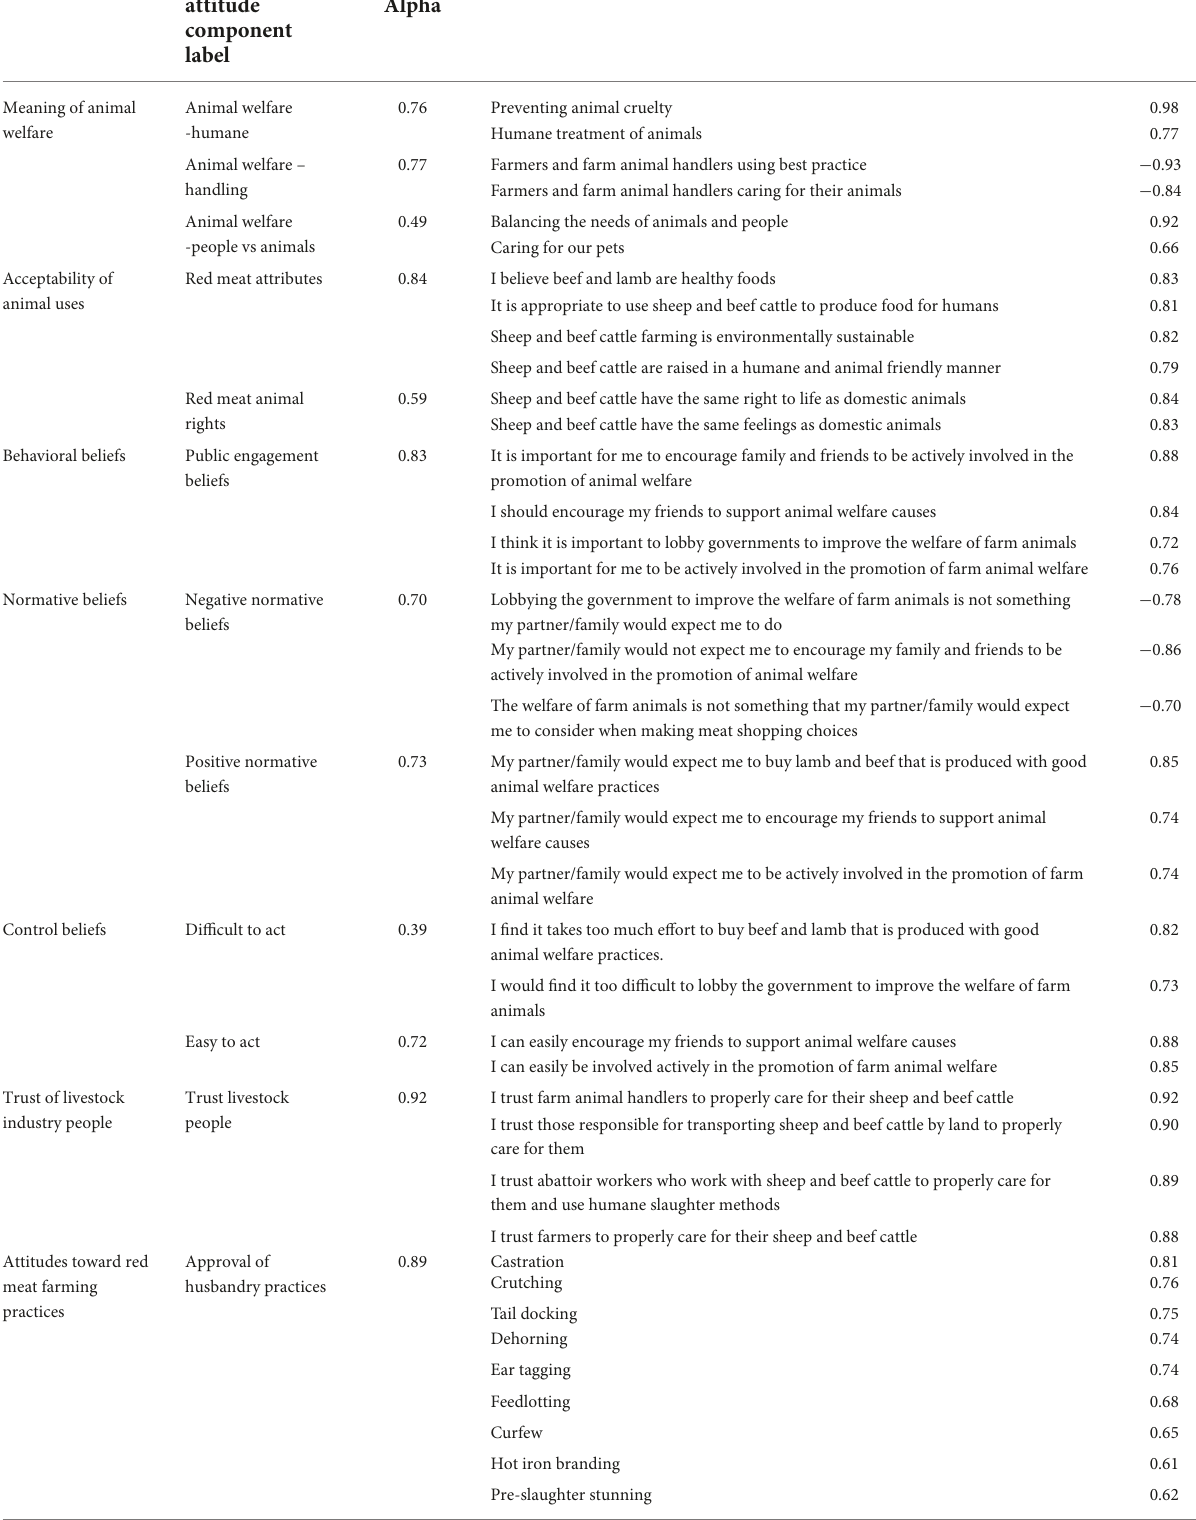
TABLE 2 Components from the questionnaire grouped into composite scores, with a high score (on a 5-point scale) indicative of a positive attitude to or strong agreement with the statements (questionnaire